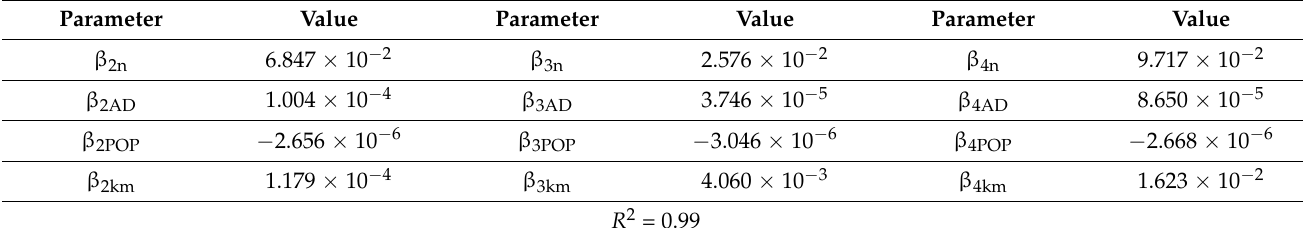
Table 1. Calibrated